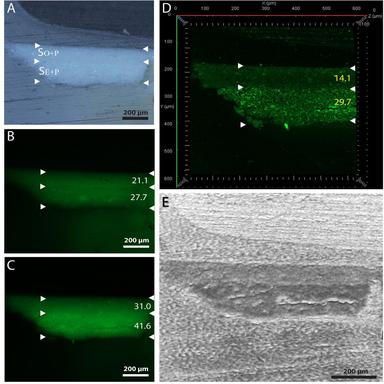
Cross section images of the white coloured micro (model) sample, containing the pigment lead white, photographed prior to antibody hybridisation using the reflected-light brightfield observation (texp 1 ms; frame A) and the widefield fluorescence observation (texp 110 ms, frame B) modes. After antibody hybridisation, the sample was again captured in the widefield fluorescence observation mode under the same illumination conditions (frame C) and was laser scanned using confocal fluorescence microscopy (maste